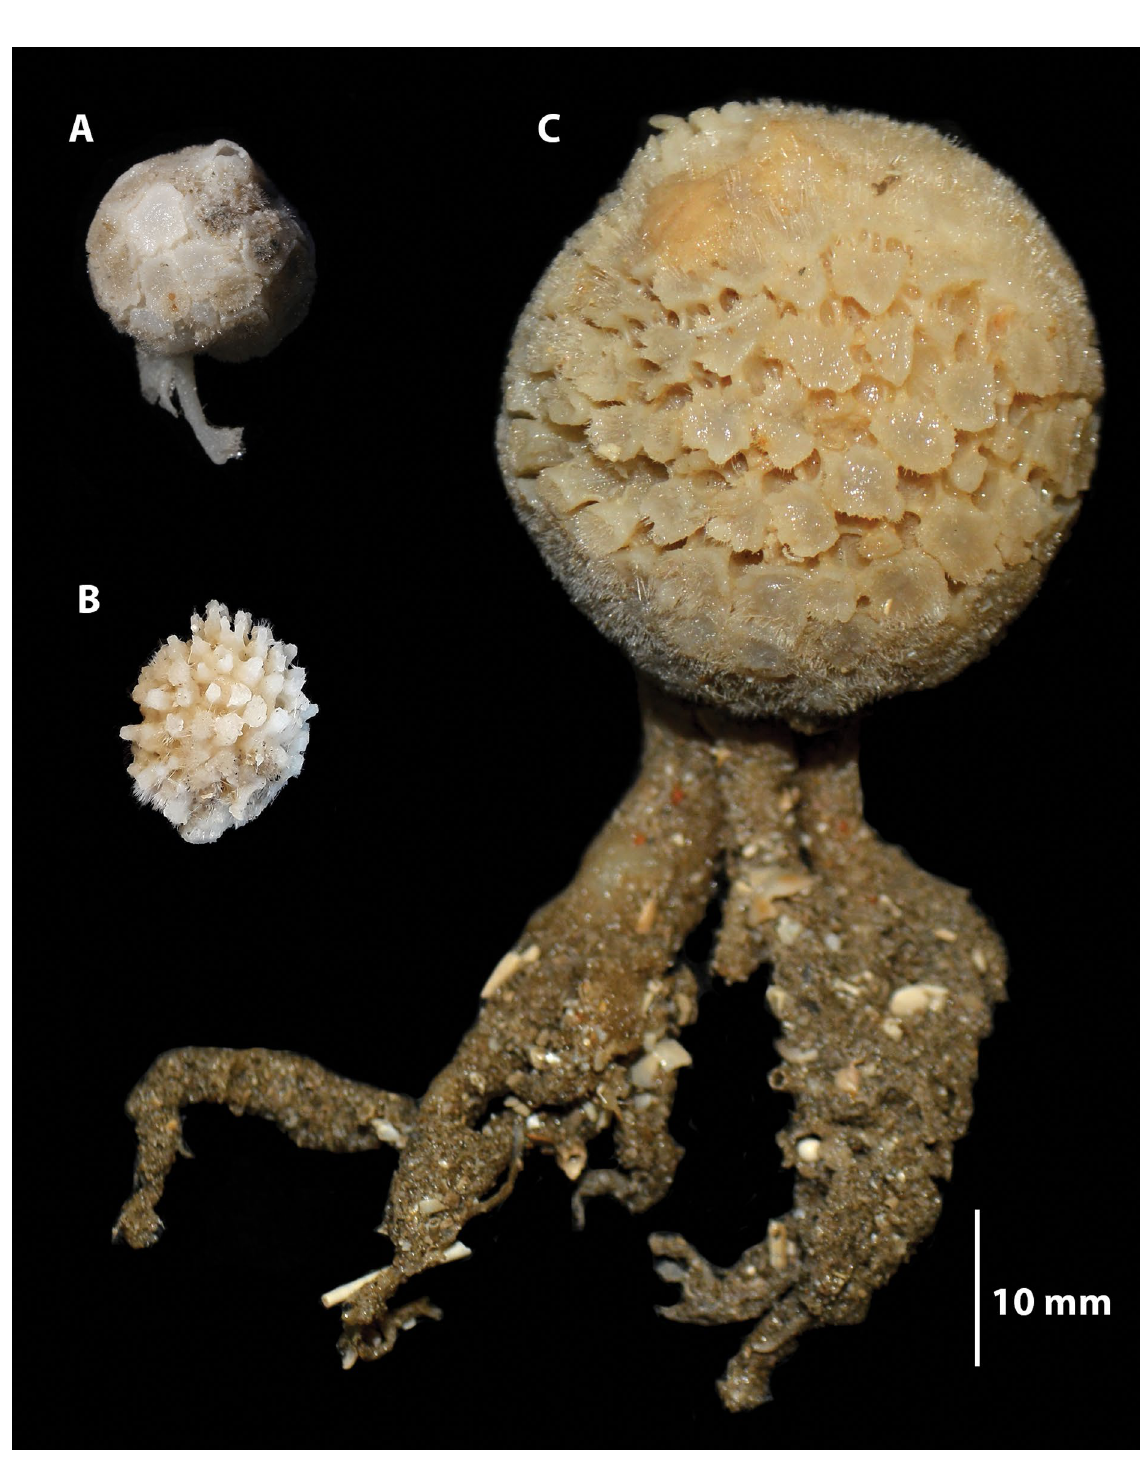
Fig. 4. Comparative sizes and external morphology of species of Tethya Lamarck, 1815. A . Tethya irisae sp. nov., holotype (SAMA S3387). B . Tethya bullae Bergquist & Kelly-Borges, 1991, part of the holotype (AM Z5074). C . Tethya fissurata Lendenfeld, 1888, syntype (AM G.9069) Note: the original photo of T. bullae (Bergquist & Kelly-Borges 1991) shows rooting